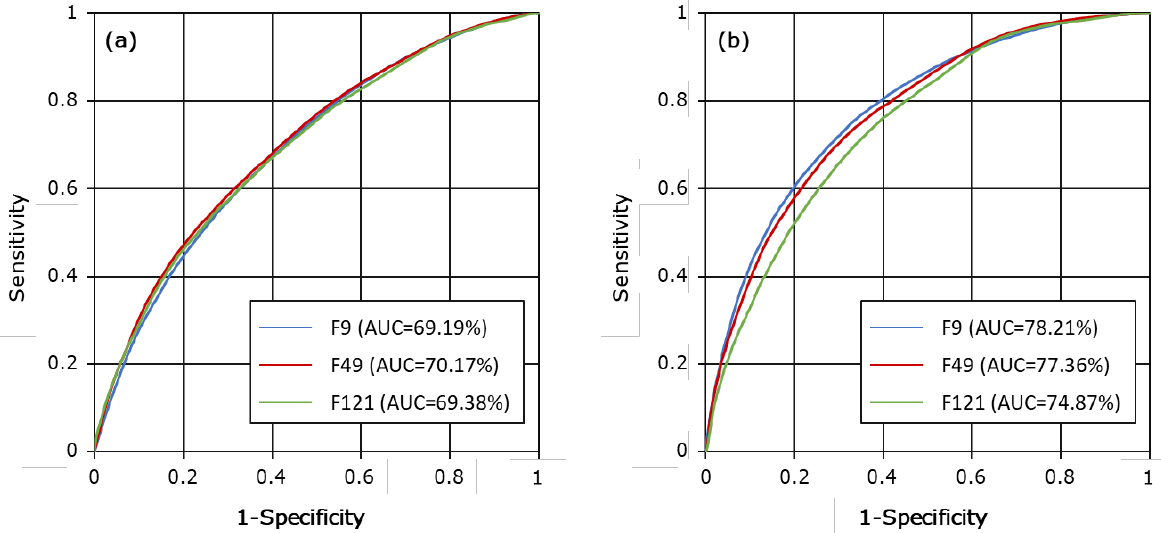
Figure 3. Receiver operating characteristic curves for the landslide susceptibility zoning maps obtained applying different focal statistic characteristic dimensions for Vaglio Basilicata ( a ) and Trivigno ( b ).